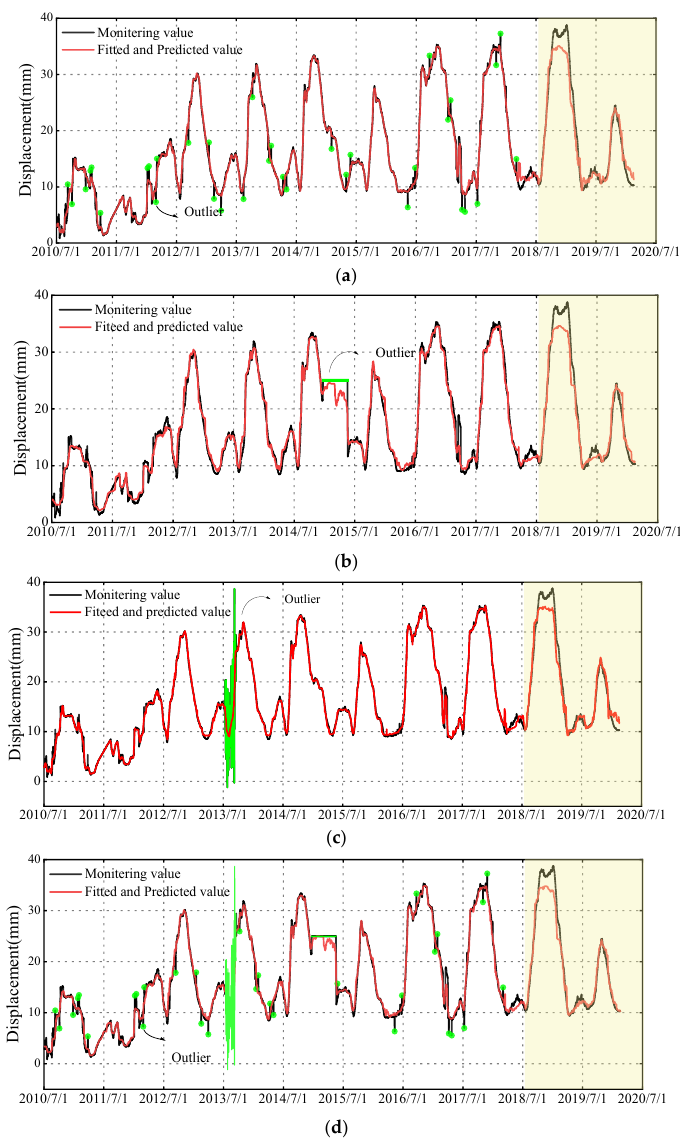
Figure 13. Predicting and fitting results of the proposed model in four noise modes. ( a ) Mode 1: point - scattered type. ( b ) Mode 2: step type. ( c ) Mode 3: vibrating type. ( d ) Mode 4: Mixed type .